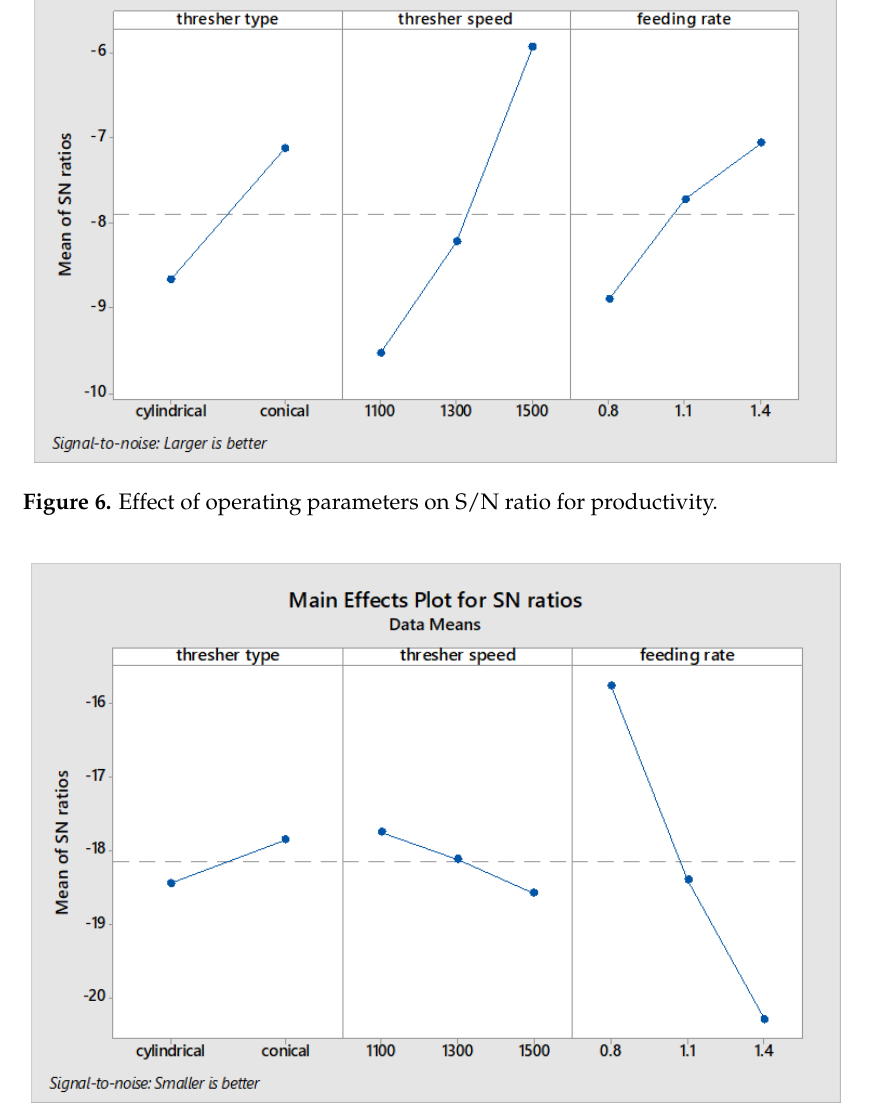
Figure 6. Effect of operating parameters on S/N ratio for productivity. Table 7. Response table for signal to noise ratios for power (smaller is better).